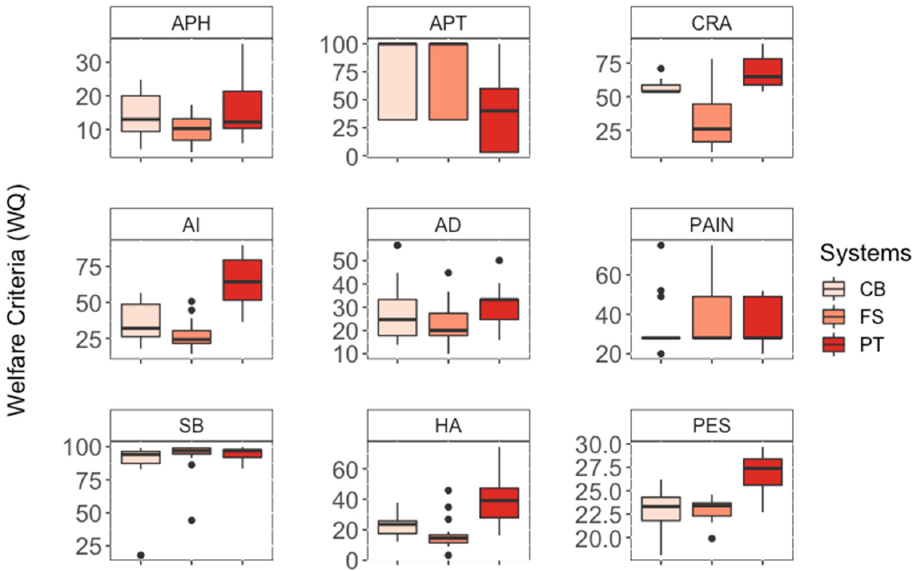
Figure 1. Box-plot of the Welfare Quality ® ( WQ ) protocol criteria: “Absence of Prolonged Hunger” ( APH ), “Absence of Prolonged Thirst” ( APT ), “Comfort in the Rest Area” ( CRA ), “Absences of Injuries” ( AI ), “Absence of Diseases” ( AD ), “Absence of Pain Induced by Management Procedures” ( PAIN ), “Social Behaviors” ( SB ), “Good Human–Animal Relationship” ( HA ) and “Positive Emotional State” ( PES ), in compost barn ( CB ), free stall ( FS ) and pasture-based ( PT ) management systems.